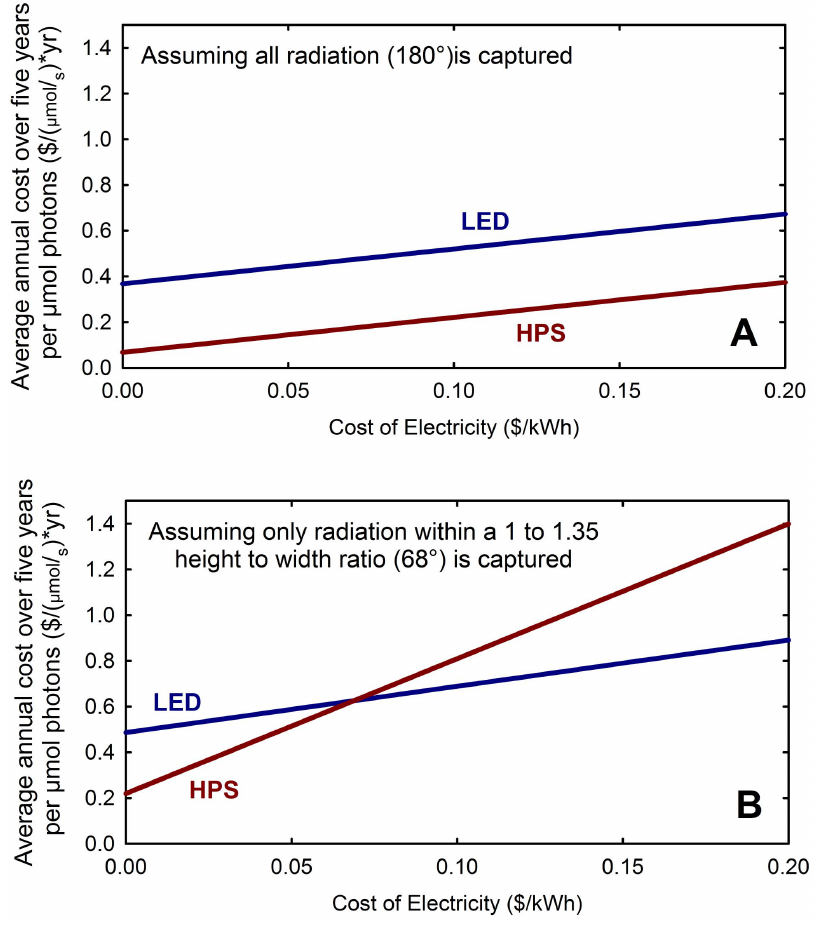
Figure 5. Effect of electricity price on average annual cost over five years for two capture scenarios. (A) When all radiation is assumed captured, the most efficient HPS fixture (Gavita) has a lower average annual five-year cost per photon than the most efficient LED fixture (Red/Blue fixture, Lighting Sciences Group). (B) When only a narrow region below the fixture (68 u ) is considered to be captured (e.g. on benches), the LEDs can have a lower cost per photon then HPS fixtures, but the cost per photon increases for both